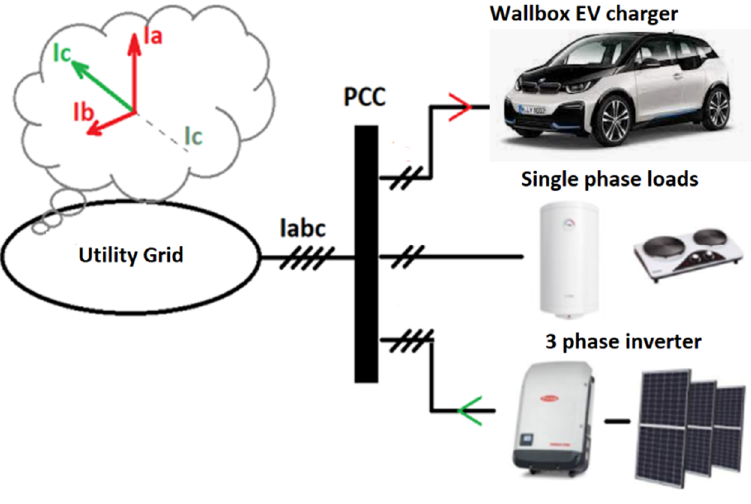
Figure 1. A case of a household treated as an asymmetrical load.